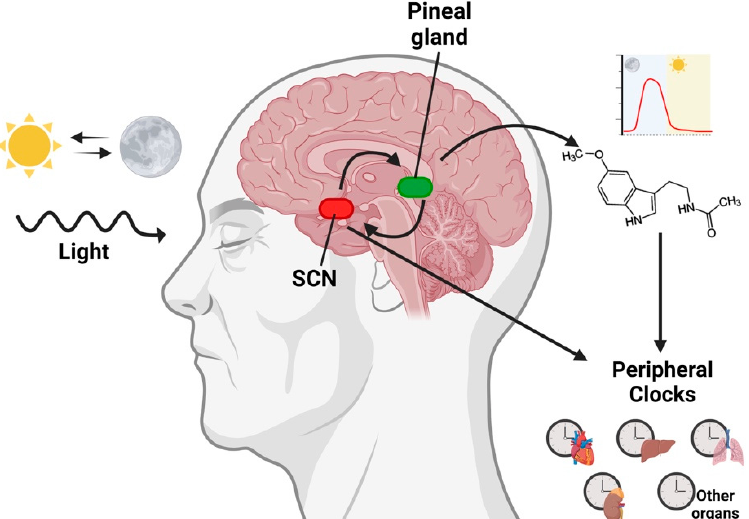
Figure 2. Schematic representation of the role of melatonin in the circadian system. In mammals, circadian rhythms are regulated by circadian clocks. The central clock is located in the SCN of the hypothalamus and controls pineal melatonin secretion in the absence of light, while melatonin also affects the SCN, which regulates chronobiotic activities. In peripheral tissues, clock genes are synchronized by the SCN and are also influenced by melatonin. Suprachiasmatic nucleus (SCN). Image created using BioRender.com (accessed on 22 November 2022).